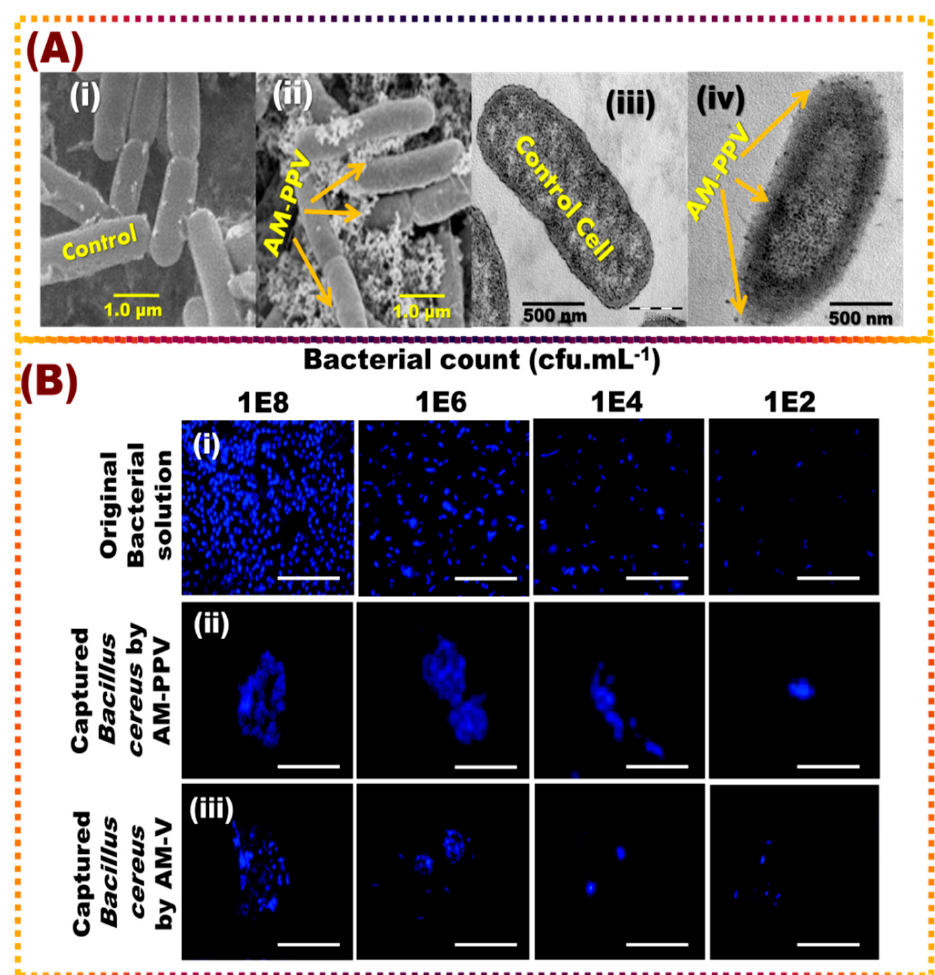
Figure 4. ( A ) SEM micrographs of the control (i) and the captured Bacillus cereus ( B. cereus ) which was conjugated with AM-PPV NSs (ii) and TEM micrographs of the B. cereus control (iii) and the captured B. cereus (iv) showing the attached AM-PPV NSs on the bacterial cell membrane; ( B ) fluorescence images of the captured B. cereus bacteria by furry AM-PPV NSs and direct AM-VCM. The concentrations of B. cereus stained by fluorescence dye ranged from 1 × 10 2 to 1 × 10 8 CFU/mL. Scale bars: 50 μ m.